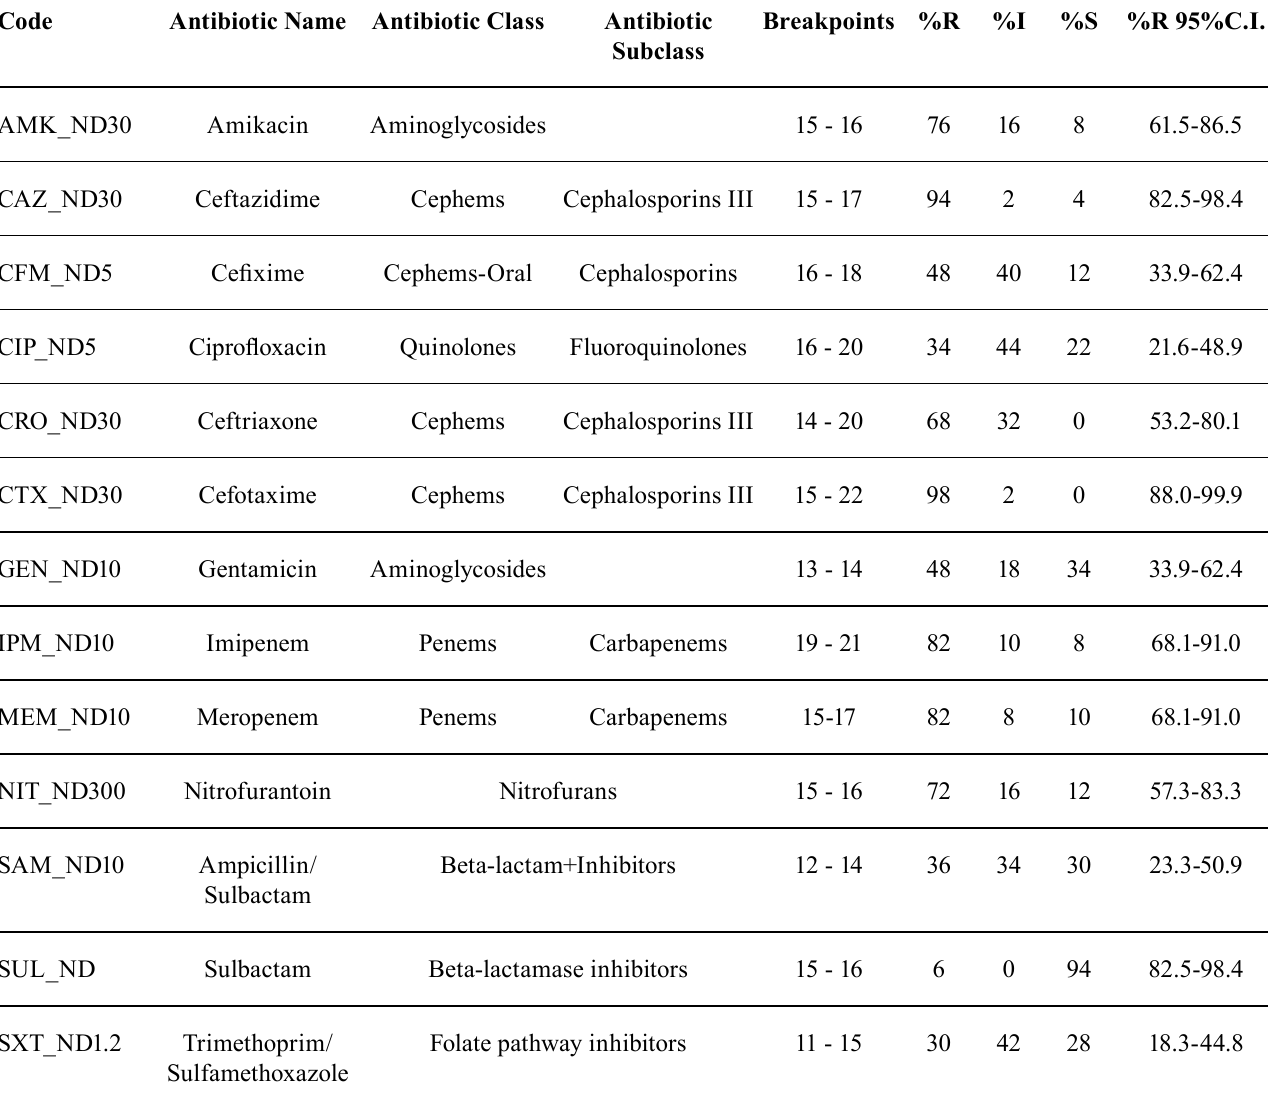
TABLE I – A ntibiotic susceptibility testing results for clinical isolates of A. baumannii